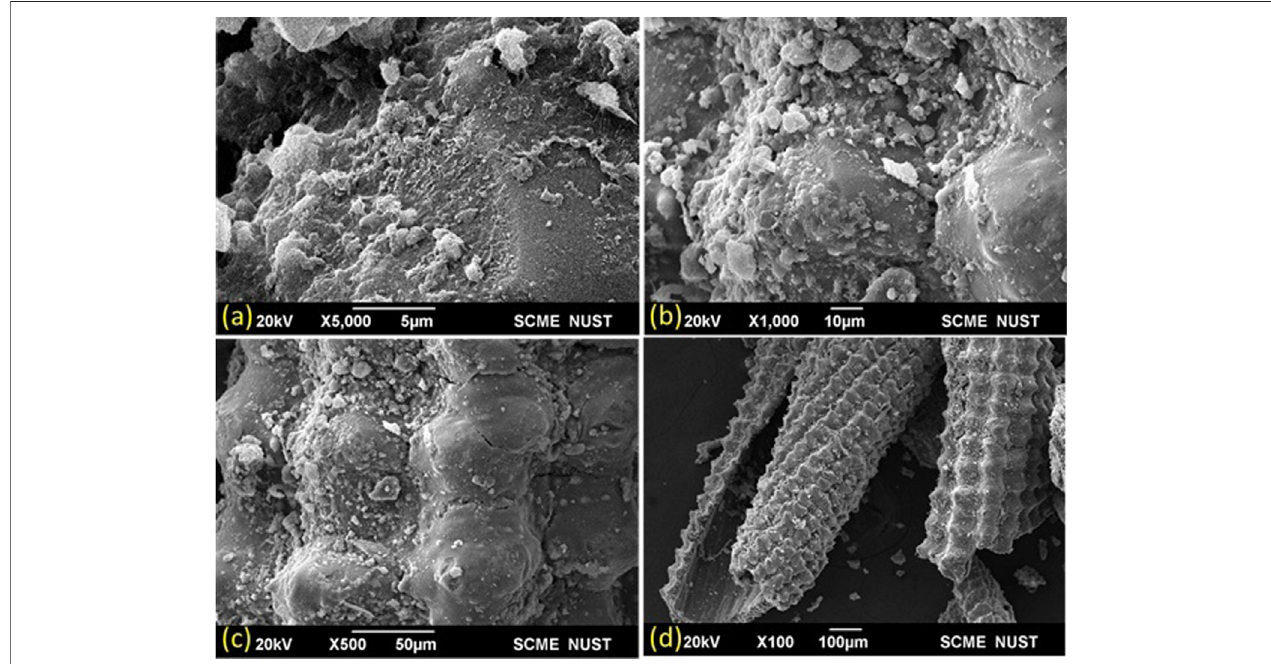
FIGURE 2 | SEM (Scanning electron microscopy) images of the prepared poultry manure biochar. (A) 5000, (B) 1000, (C) 500, (D) 100.